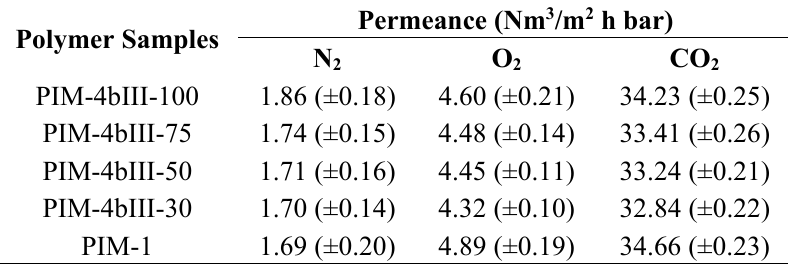
Table 2. Gas permeance of PIM-1, homopolymer and